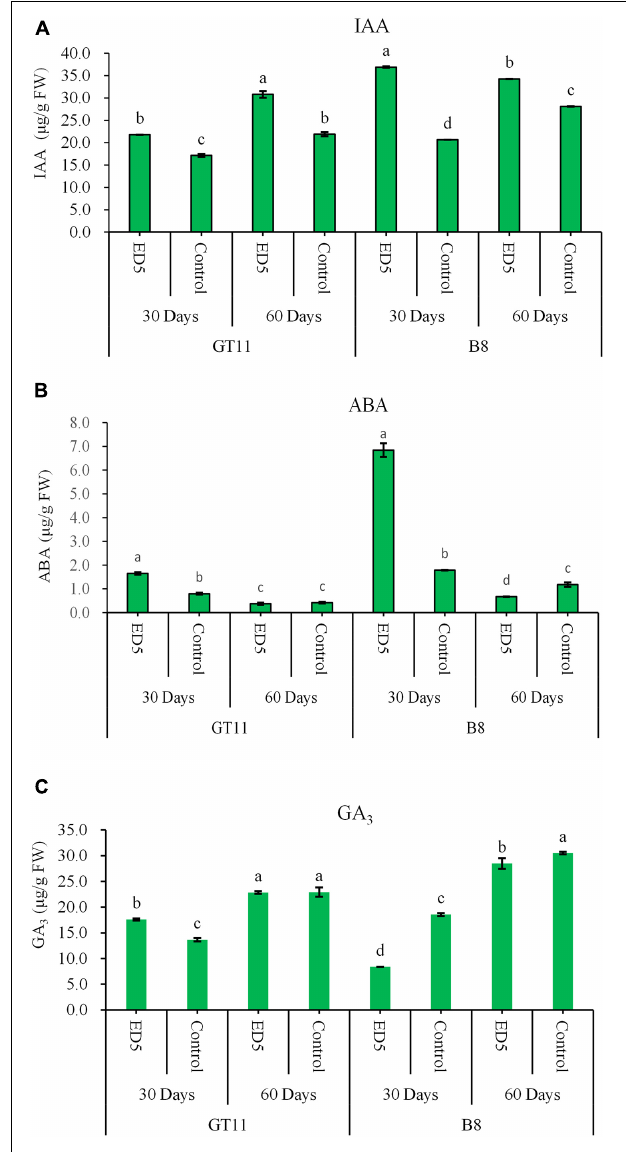
FIGURE 2 | Variations in contents of phytohormones in the leaf of sugarcane varieties GT11 and B8 inoculated with E. roggenkampii ED5 as compared to control at 30 and 60 days after the treatment. (A) Indole acetic acid (IAA), (B) abscisic acid (ABA), and (C) gibberellin (GA 3 ). At the level of p < 0.05, different letters indicate significant changes between